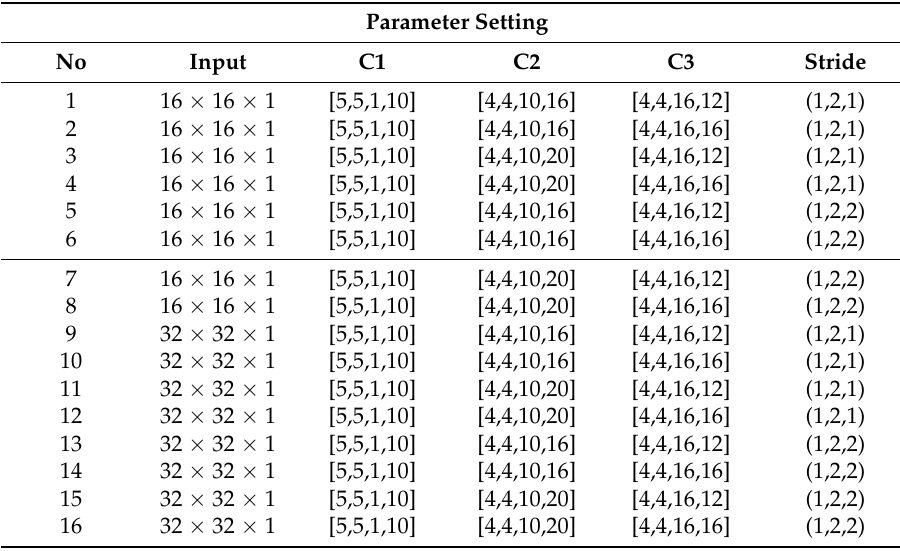
Table 2. Structures and parameters of the proposed CNNs.